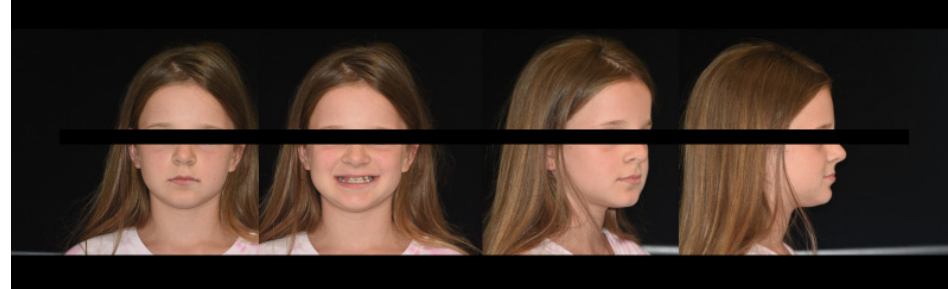
Figure 3. Extraoral facial analysis.